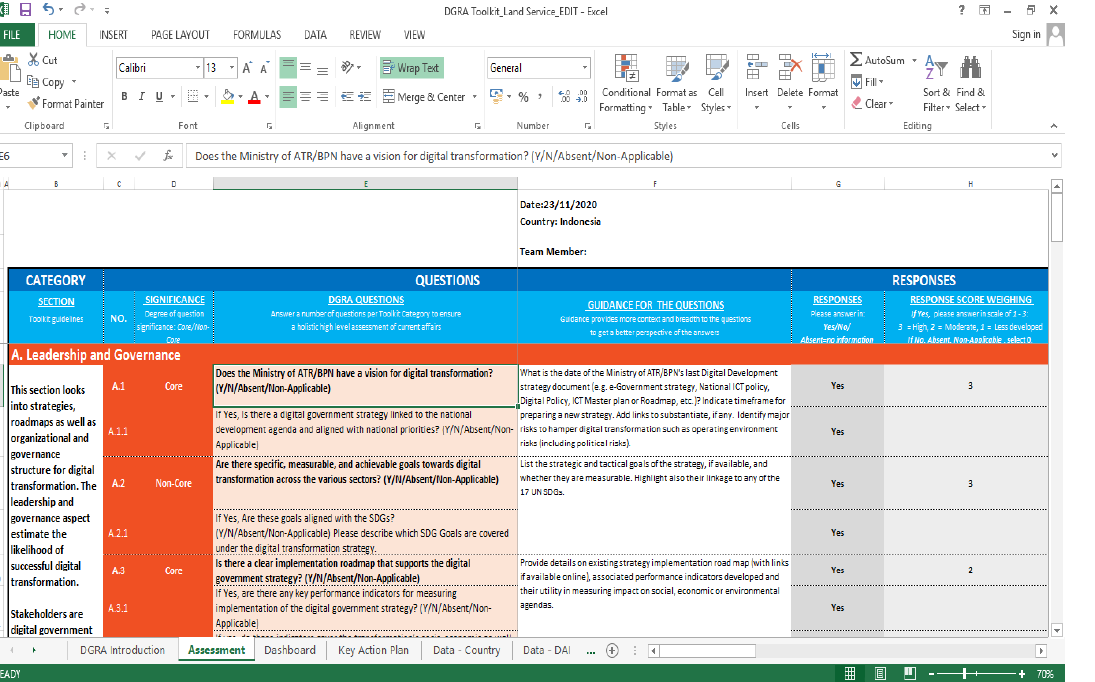
Figure 5. The DGRA for land services adapted from the World Bank DGRA Toolkit [21].